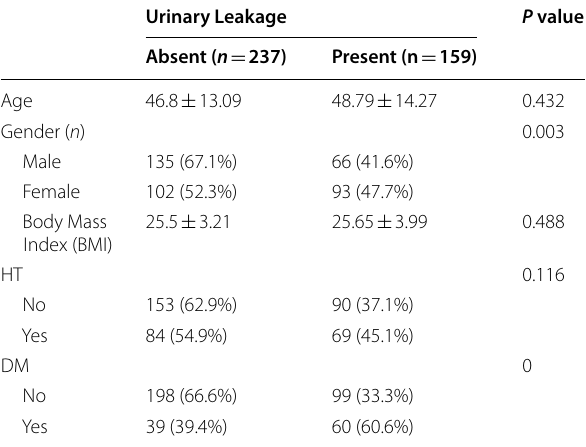
Table 1 Impact of patient related factors on urinary leakage